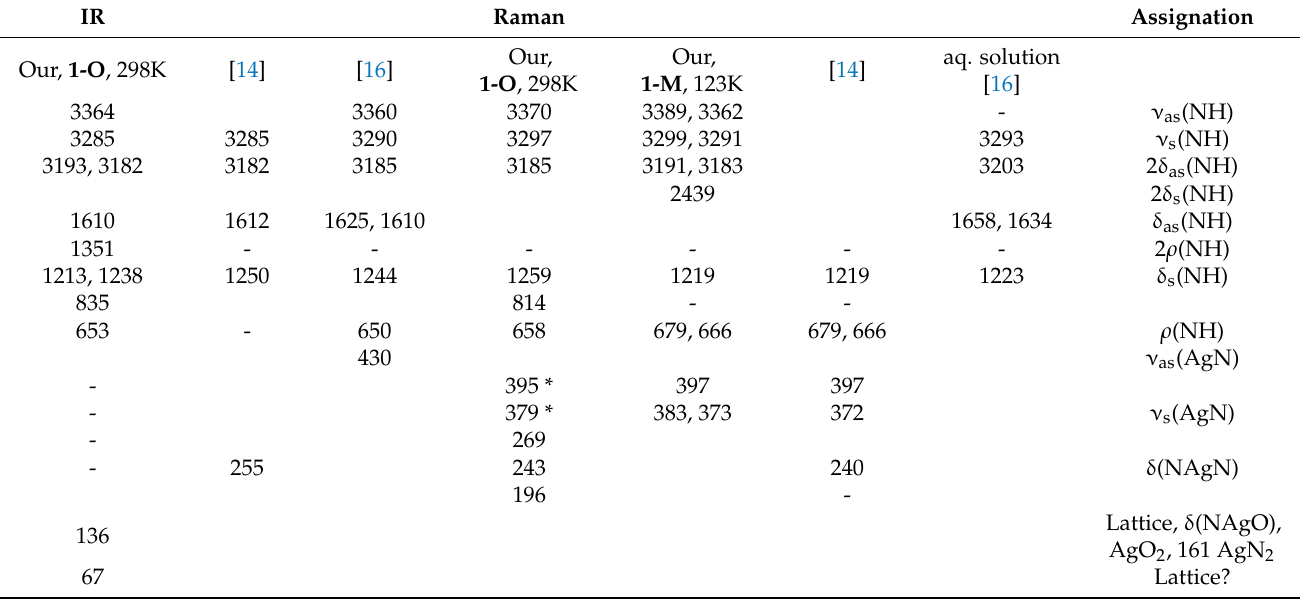
Table 2. Assignment of bands belonging to cation modes in IR and Raman spectra of compound 1. (*—mixed bands). IR Raman Assignation Our, 1-O ,